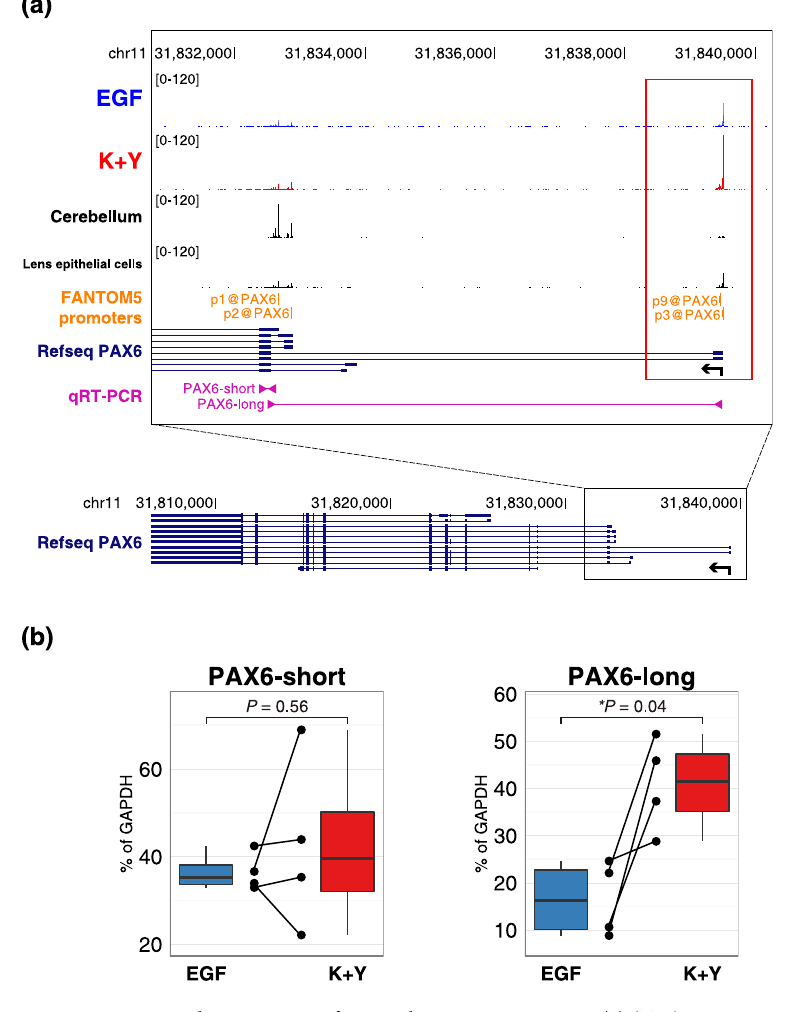
Figure 6. Genome browser view of PAX6 alternative promoters. (a) (Top) EGF represents CAGE tags of LECs cultured with EGF (blue). K + Y represents CAGE tags of LECs cultured with KGF and Y-27632 (red). CAGE tags of the 4 LEC samples cultured in distinct conditions were merged and normalized. p3 and p9@PAX6, indicated by a red rectangle, were highly expressed in K + Y-treated LECs and lens epithelial cells, whereas their expression levels were low in EGF-treated LECs and the cerebellum. p1 and p2@PAX6 were highly expressed in the cerebellum. (Bottom) Zoomed-out view to show the full structure of the PAX6 gene. Coding exons are represented by thick blocks, whereas untranslated exons are represented by relatively thin blocks. Arrows indicate the direction of transcription. (b) Expression levels of two types of PAX6 transcripts quantified by RT-PCR. The primer positions of each transcript are shown in (a) . PAX6-short reflects the activity of p1@ PAX6, and PAX6-long reflects the activities of p3 and p9@PAX6. Each dot represents the expression level in each sample, and each line indicates binding to samples from the same donors. An asterisk represents statistical